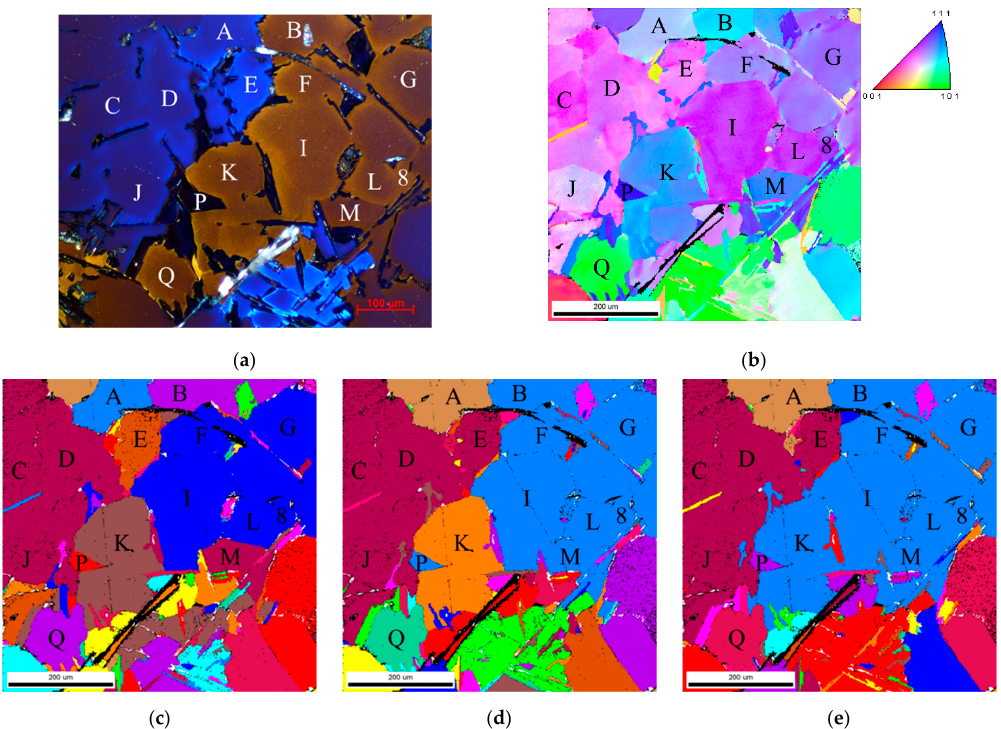
Figure 7. As-cast EMS billets, sand mold, poured at 690 ◦ C; ( a ) polarized light image with sensitive tint plate, polished and anodized with Barker’s reagent, ( b ) IPF map, ( c ) 5 ◦ grain map, ( d ) 10 ◦ grain map, ( e ) 15 ◦ grain